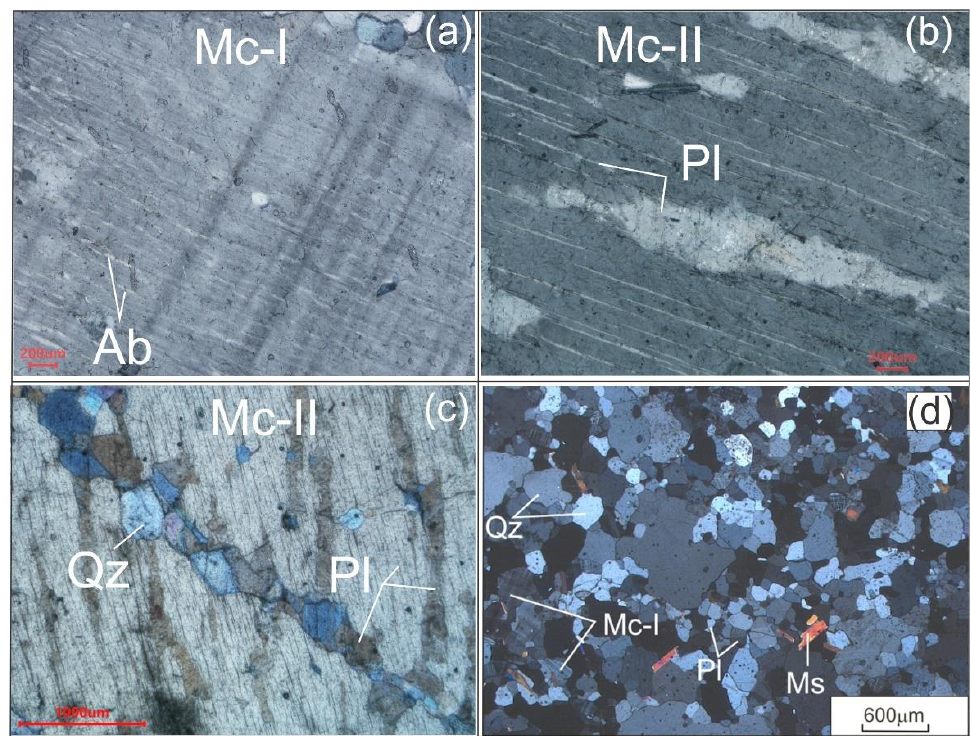
Figure 4. ( a ) Photomicrographs (plane polarized light) of Mc-I sections from albite-spodumene pegmatites. In Mc-I, microscopic investigation revealed micro-perthite texture ( b , c ). Photomicrographs (plane polarized light) of Mc-II sections from albite-spodumene pegmatites. Microscopic investigation reveals micro-perthite texture in Mc-II. Plagioclase in ( b ) forms vein perthite and film perthite. The quartz-plagioclase veinlet in ( c ) intersects the perthite texture in Mc-II. ( d ) Photomicrographs (plane polarized light) of Mc-I sections from feldspar pegmatites. Ab, albite; Qz, quartz; Pl, plagioclase; Mc, microcline; Ms, mus с ovite.